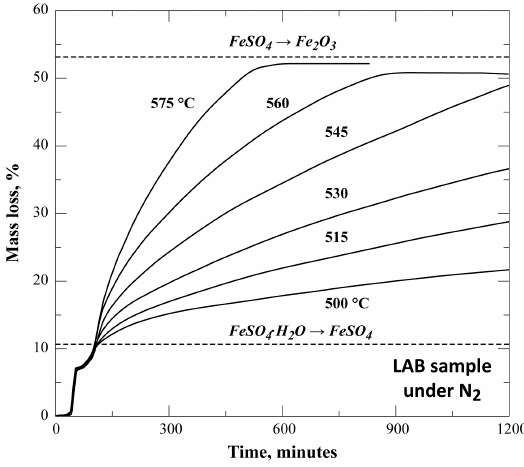
Figure 8. Evolution of the % ML as a function of time during the isothermal treatment of a laboratory sample under nitrogen between 500 and 575 °C.